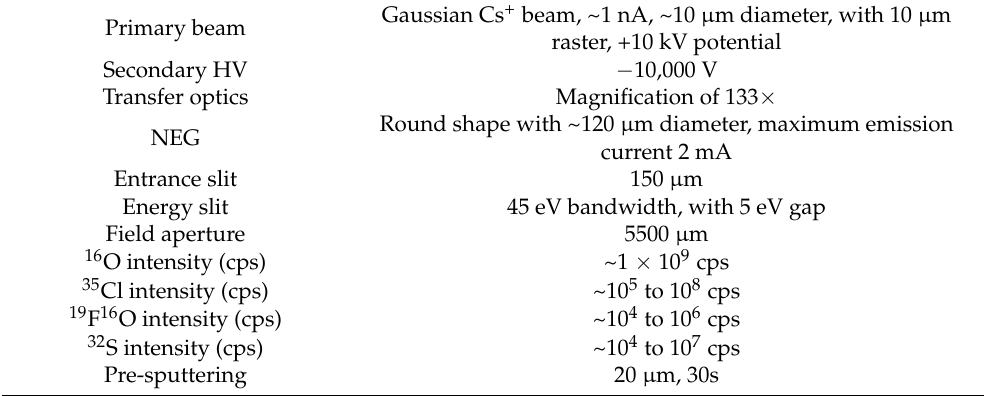
Table 2. Analytical conditions used for SIMS determination.